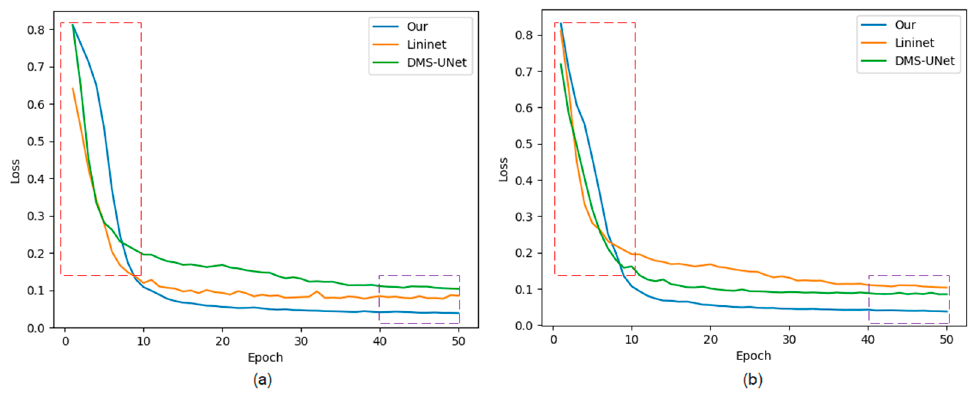
Figure 10. The loss curves of the proposed network, Linknet, and DMS-UNet on two databases: ( a ) IITD and ( b ) UBIRIS.V2. Red frame: the early stage of network training; purple frame: the later stage of network training.